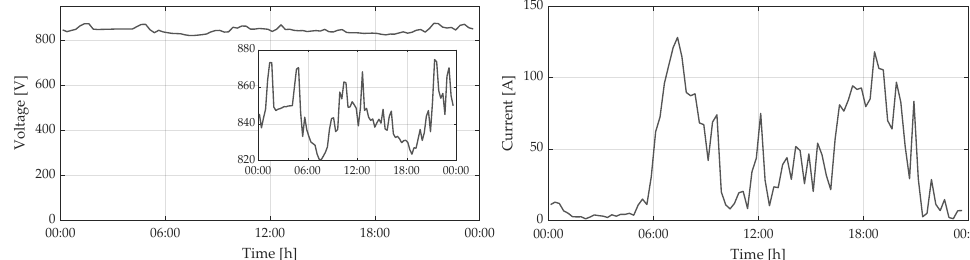
Figure 10. Voltage ( left ) and current ( right ) measurements in TS T-T in an average window of 15 min. The plots cover a 24-h simulation scenario.